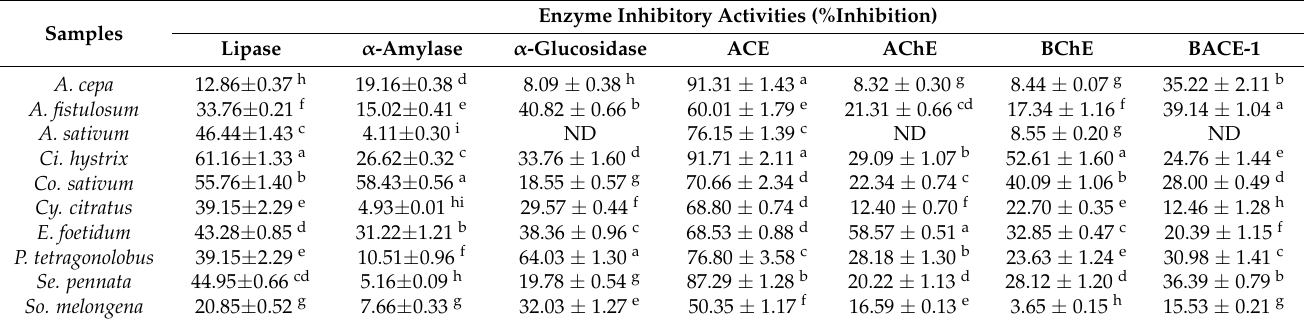
Table 4. Enzyme inhibitory activities of the ten vegetable